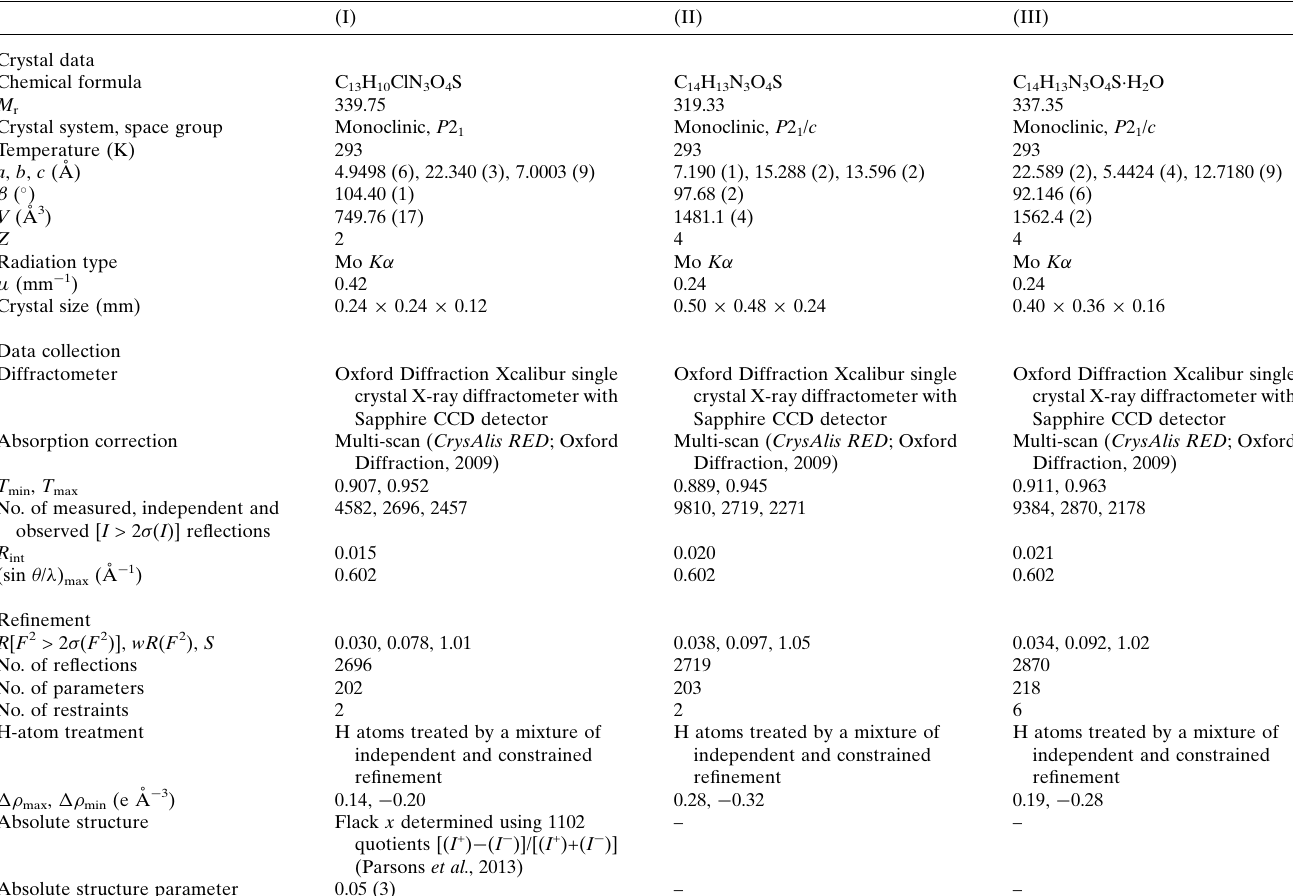
Table 5 Experimental details.